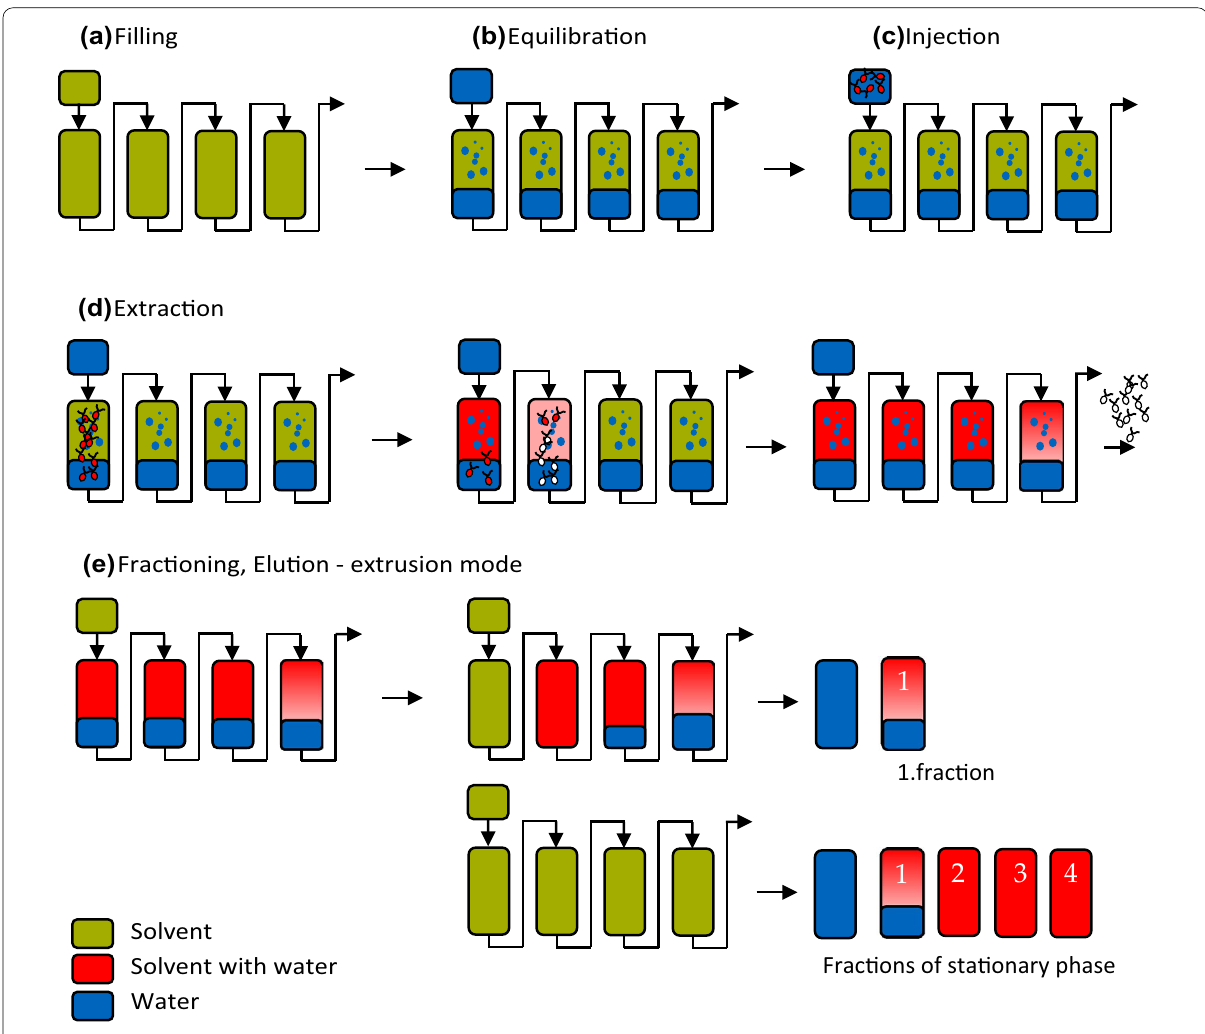
Fig. 2 Schematic presentation of the extraction of astaxanthin into a solvent using a CPE column, including a filling the column with solvent; b equilibration with water; c injection of the algal biomass (zoospores or mechanically disrupted cyst cells); d extraction of astaxanthin from the aqueous algal broth into the solvent, and e fractioning the stationary phase in the elution–extrusion